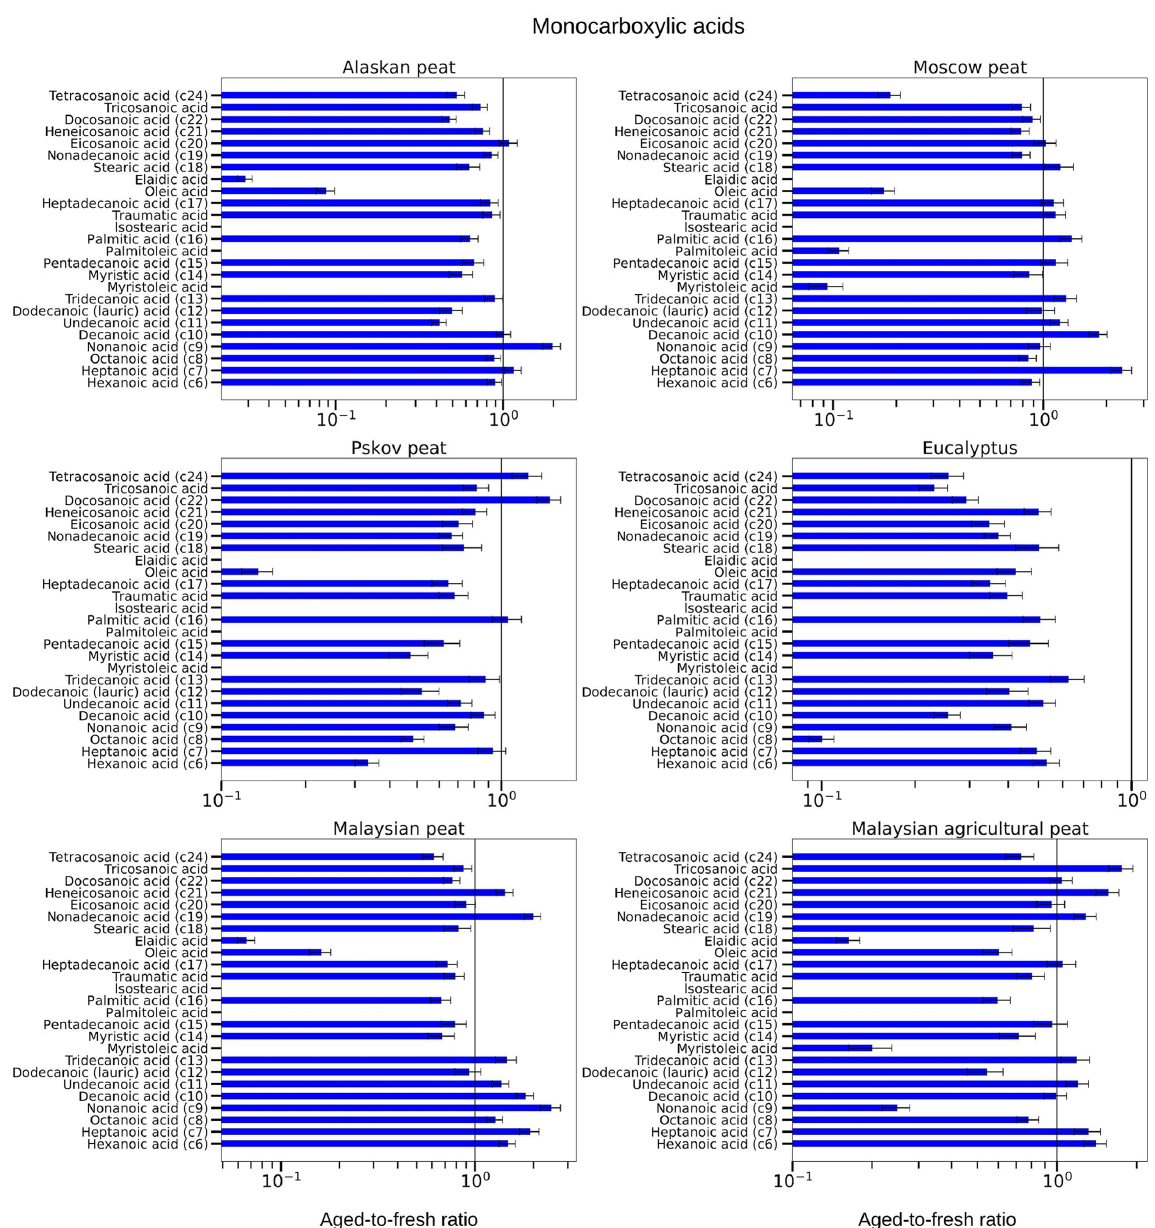
Figure 10. Aged-to-fresh ratios of total (gas + particle) EFs for monocarboxylic acids from biomass-burning emissions for six different biomass types presented in log scale. We did not burn fuels in replicates, and the standard-deviation (SD) values were calculated based on replicate analysis of similar fuels (with same experimental conditions) from our previous campaigns. SD values derived from EFs were scaled to